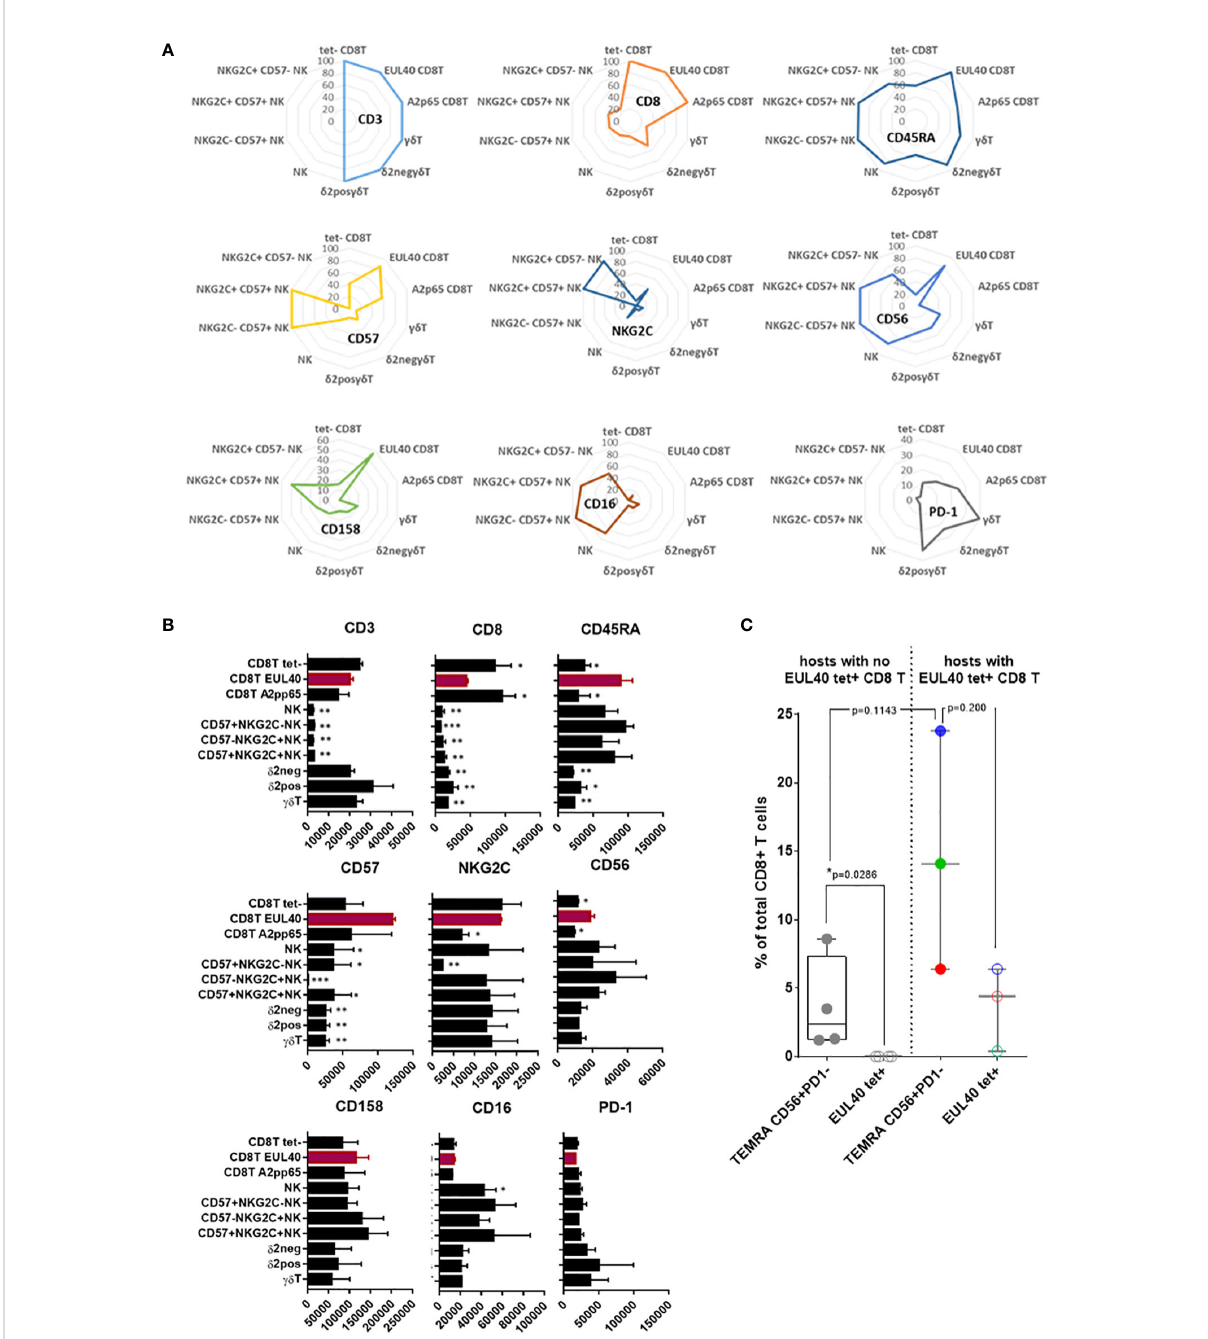
FIGURE 6 Phenotypic proximity of HLA-E UL40 CD8 ab T cells with NKG2C + CD57 + NK and d 2 - gd T cells. Immunophenotypes comparing HLA-E UL40 CD8T cells to tetramer negative (tet-) and HLA-A2 pp65 CD8 ab T, gd T and NK subsets based on their respective expression of CD3, CD8, CD45RA, CD56, CD57, PD-1, CD16, CD158 and NKG2C. Data were obtained from 4 individuals. (A) Radar plots showing the mean of percentages of expressing cells in the different cell subsets for each cell marker. (B) Histograms show the means ± SD of fl uorecence intensity for expressing cells in the different cell subsets for each cell markers. P values for comparison between HLA-E UL40 CD8T and the other immune subsets: (C) Detection of CD8T cells using, in parallel experiments, a set of markers (CD3, CD8, CD45RA, CCR7, CD56, CD57, PD-1 and CD158) or HLA- E UL40 tetramers (EUL40 tet+) for cell gating on the same PBMC from HCMV + individuals with (n=3) and without (n=4) HLA-E UL40 tet+ CD8T cells. Results are shown as box plots with medians and interquartiles values. Statistical analysis was performed by Mann-Whitney U -test. P values: *for p < 0.05, **for p<0.01, ***for